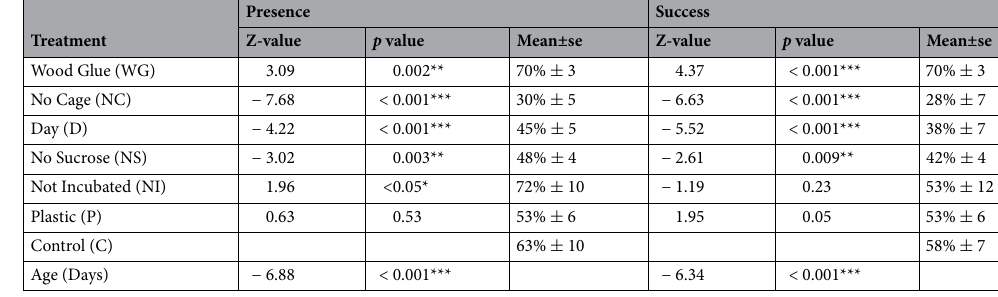
Table 2. Glmm results for models analyzing the fixed effect of treatments on presence and success over the course of the hive observations, where treatments are compared to the Control group. Asterisk denotes statistical significance with respect to the control group ( α = 0.05 ), alongside mean and se of presence and success on day two.